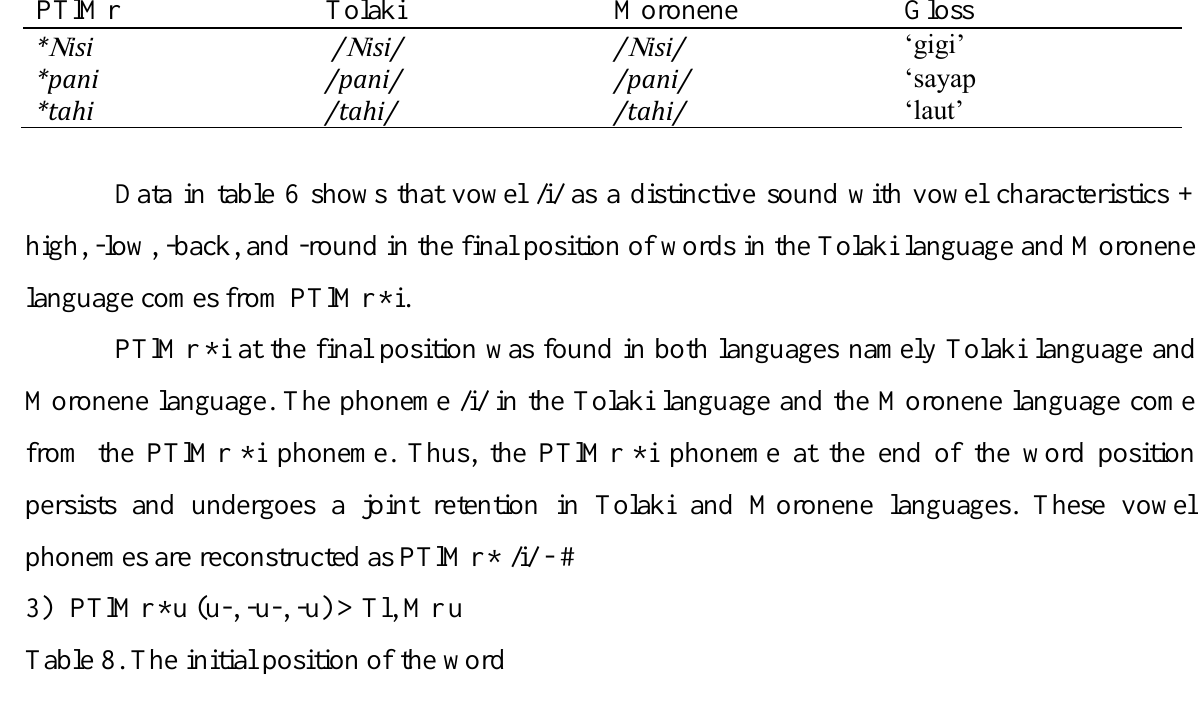
Table 8. The initial position of the